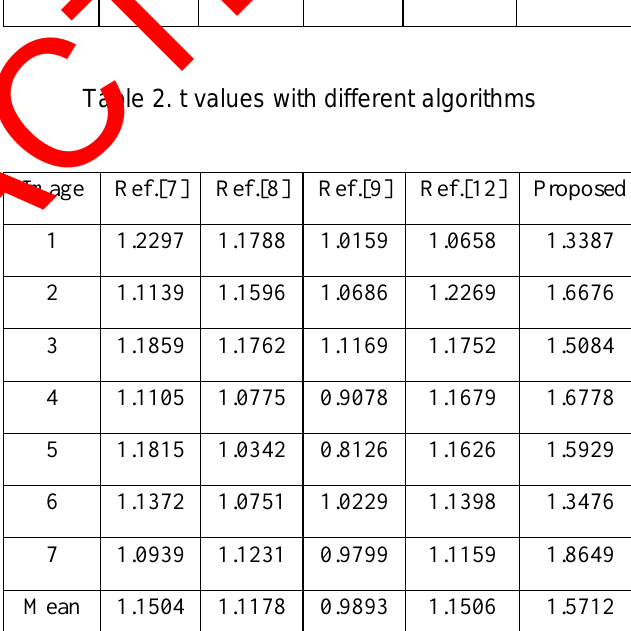
Table 2. t values with different algorithms